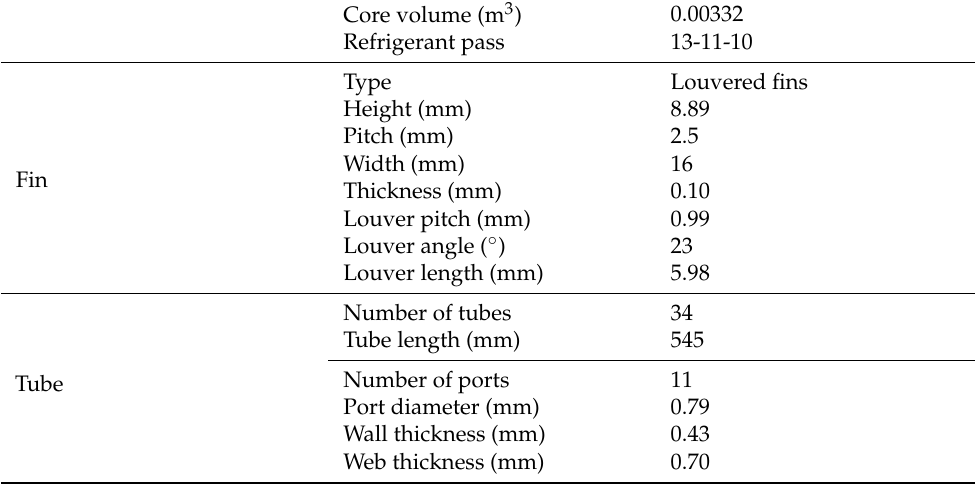
Table 1. Microchannel CO 2 gas cooler baseline geometric specifications.